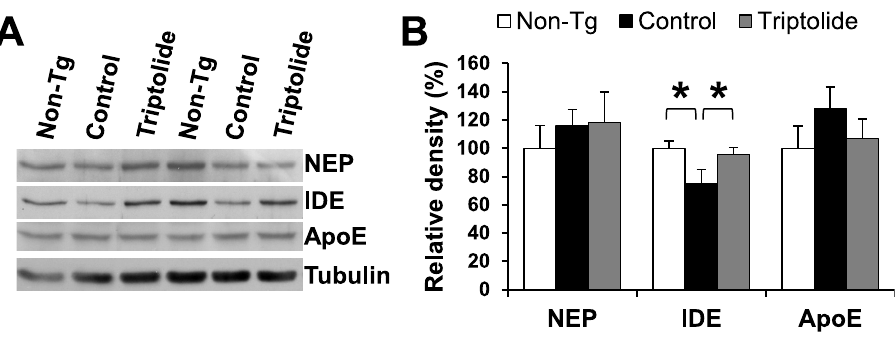
Figure 6. Effect of triptolide treatment on proteins involved in clearance/degradation of A b in APP/PS1 mice. A , Immunoblot analysis of ApoE, NEP, and IDE levels in the cerebral homogenates. B , Densitometric analysis of immunoblots (normalized by the amount of tubulin), with the levels in the non-Tg group set as 100%. The level of IDE was significantly decreased in control APP/PS1 mice but restored to the normal level in triptolide-treated APP/PS1 mice. N=7 mice/group; Age =8.6 months; *, P , 0.05.